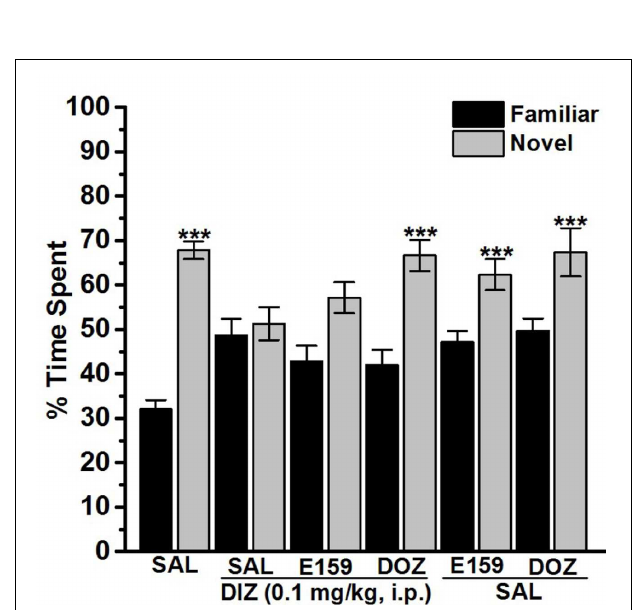
that received either E159 (2.5 mg/kg) or DZP (10 mg/kg) ( Figures 7A–D ).